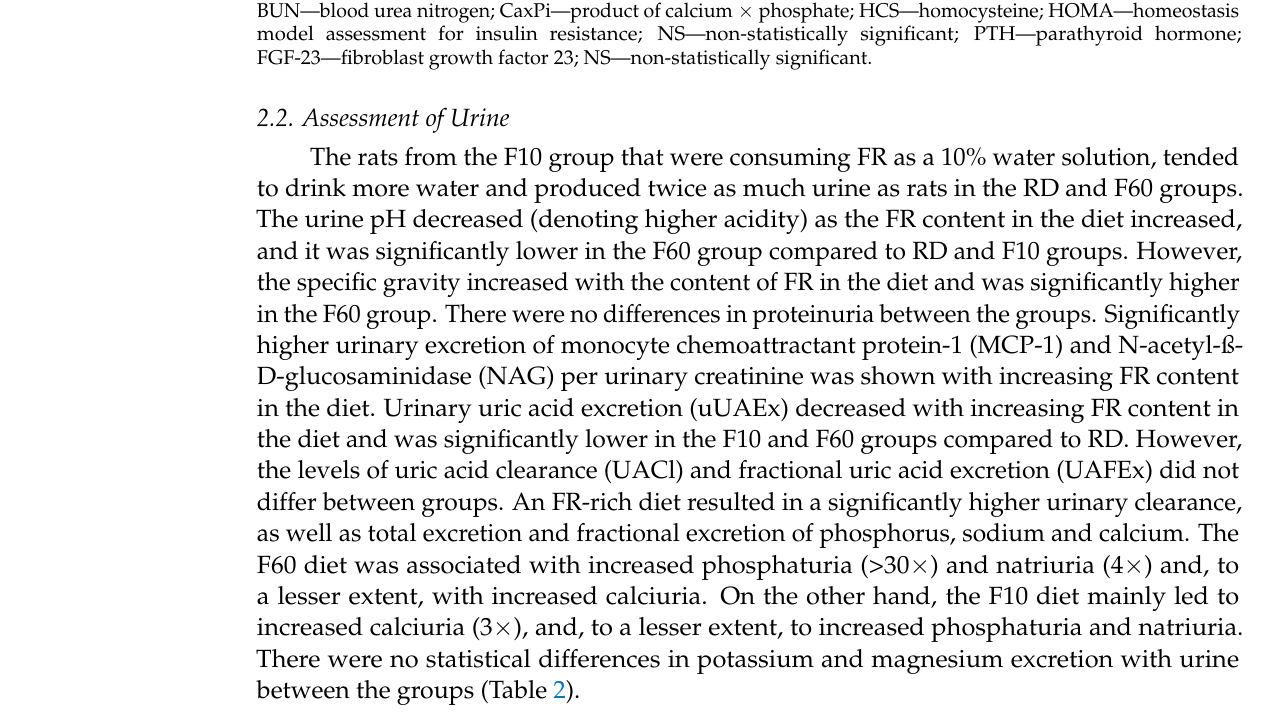
Table 2. The results of urinalysis and markers of kidney tubular function after 8 weeks period on